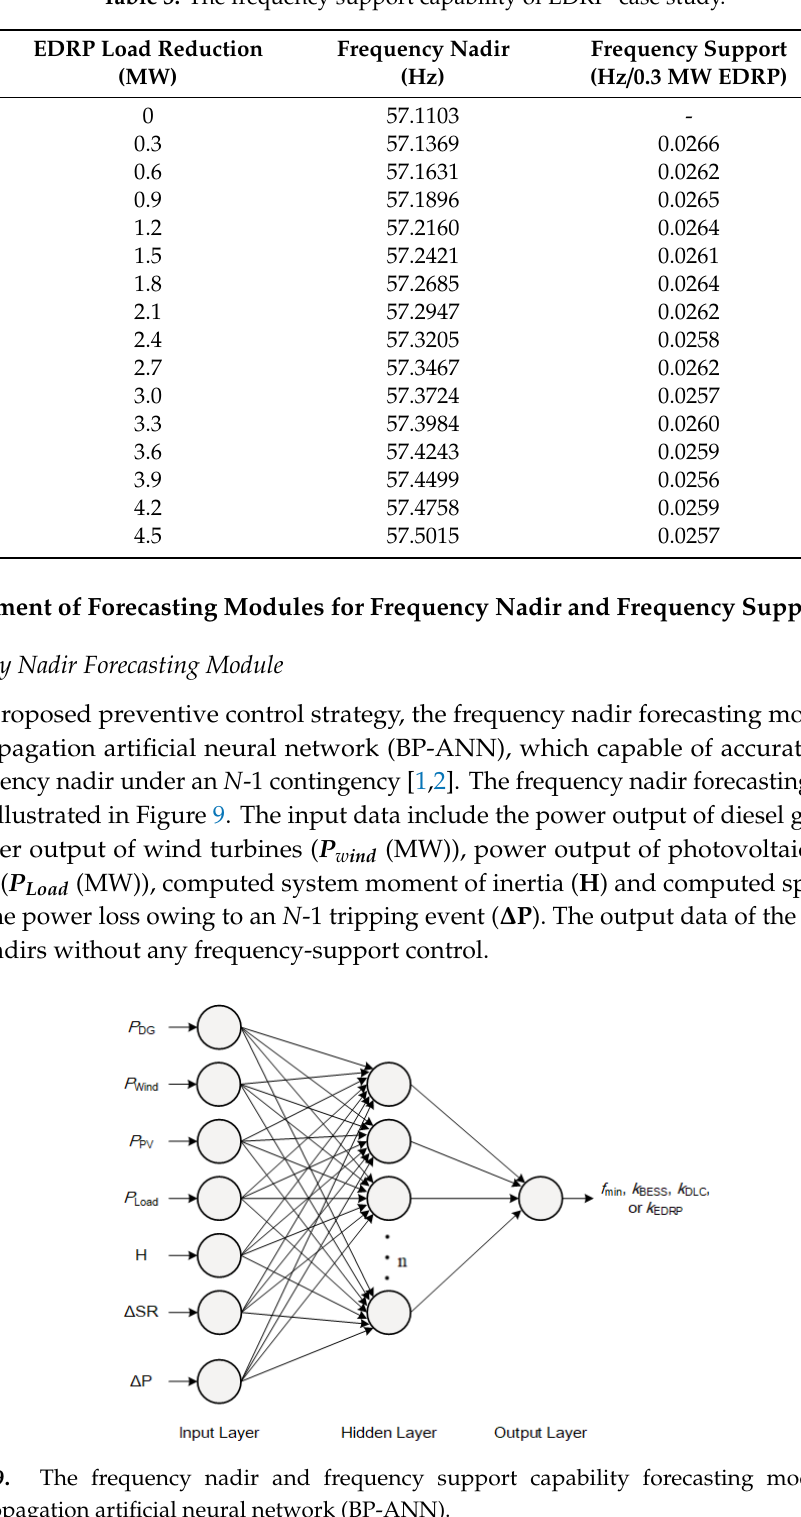
Table 3. The frequency support capability of EDRP–case study.